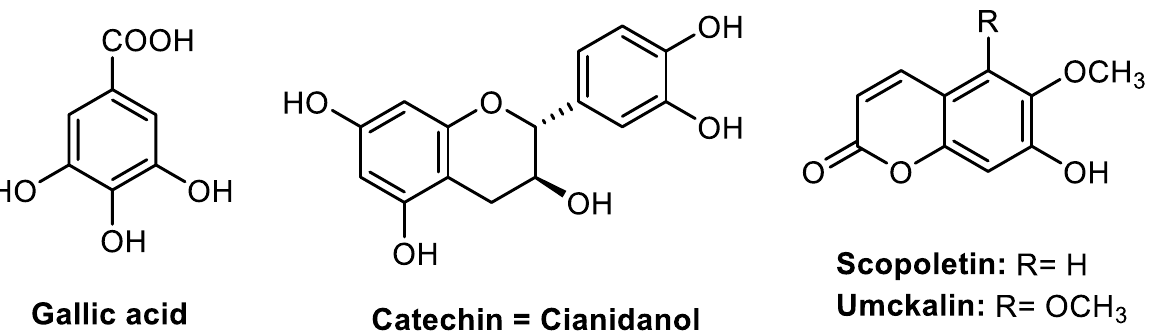
Figure 1. Chemicalstructuresofthefourstudiedbiomoleculesof Pelargoniumsidoides Figure 1. Chemical structures of the four studied biomolecules of Pelargonium sidoides in phytoprep- arations.